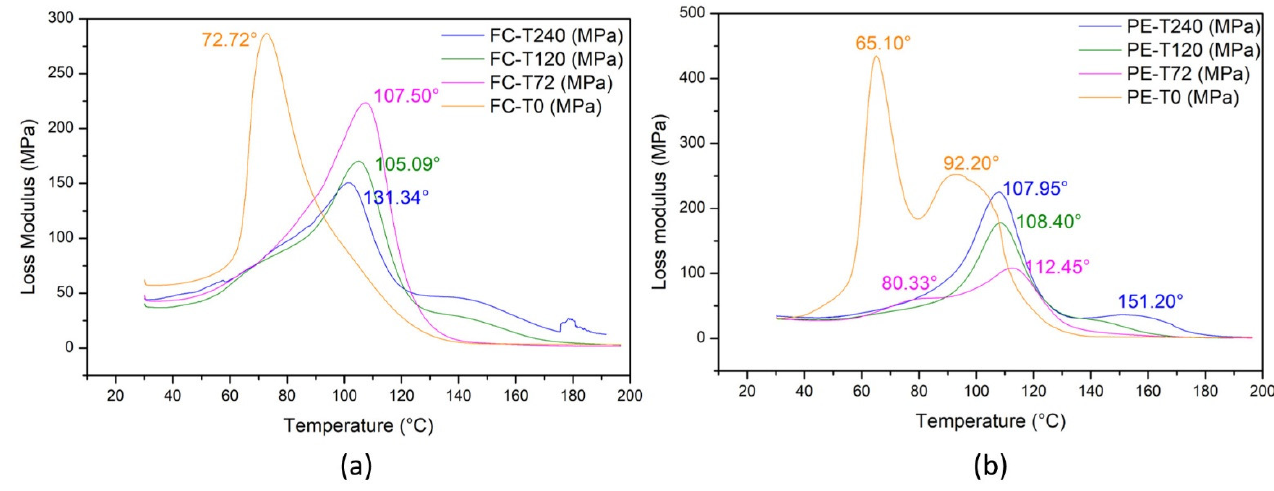
Figure 9. Loss modulus (E”) vs. temperature with glass transition temperatures (Tg) highlighted for samples unaged and thermally aged at different conditions: ( a ) fique fabric-reinforced epoxy composites; ( b ) plain epoxy.